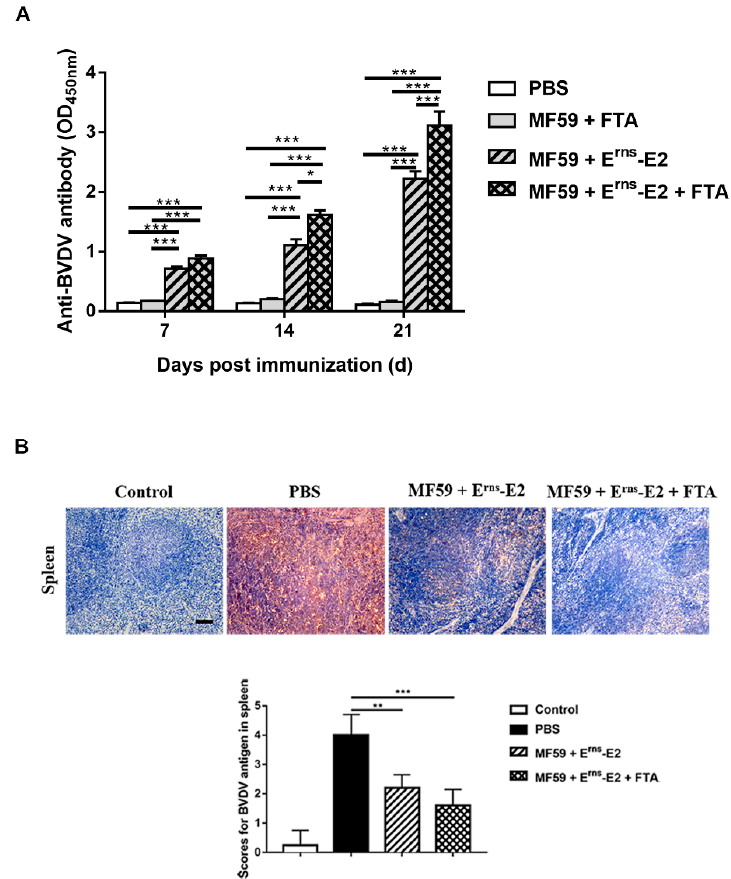
Figure 8. BVDV-specific antibody responses and the viral load of spleen tissue of mice after BVDV challenge following the recombinant E rns -E2 protein vaccine-FTA adjuvant combination treatment.